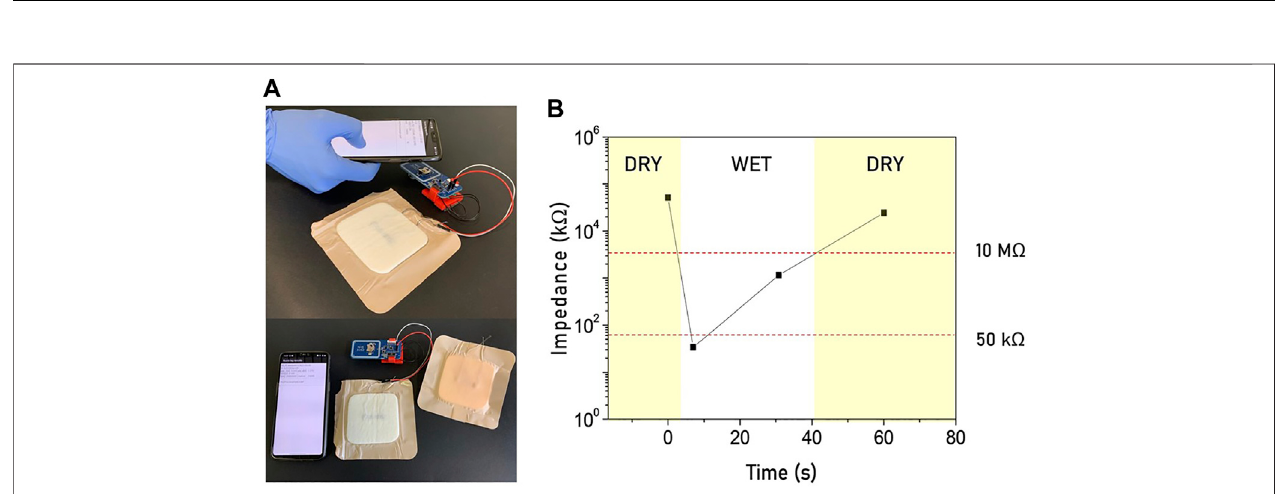
FIGURE 6 | (A) Moisture sensor embedded in a real wound dressing and attached to an NFC interface. (B) The wireless communication with a NFC reader (a smartphone) allows to perform a quantitative measurement to investigate the wound condition in real-time.